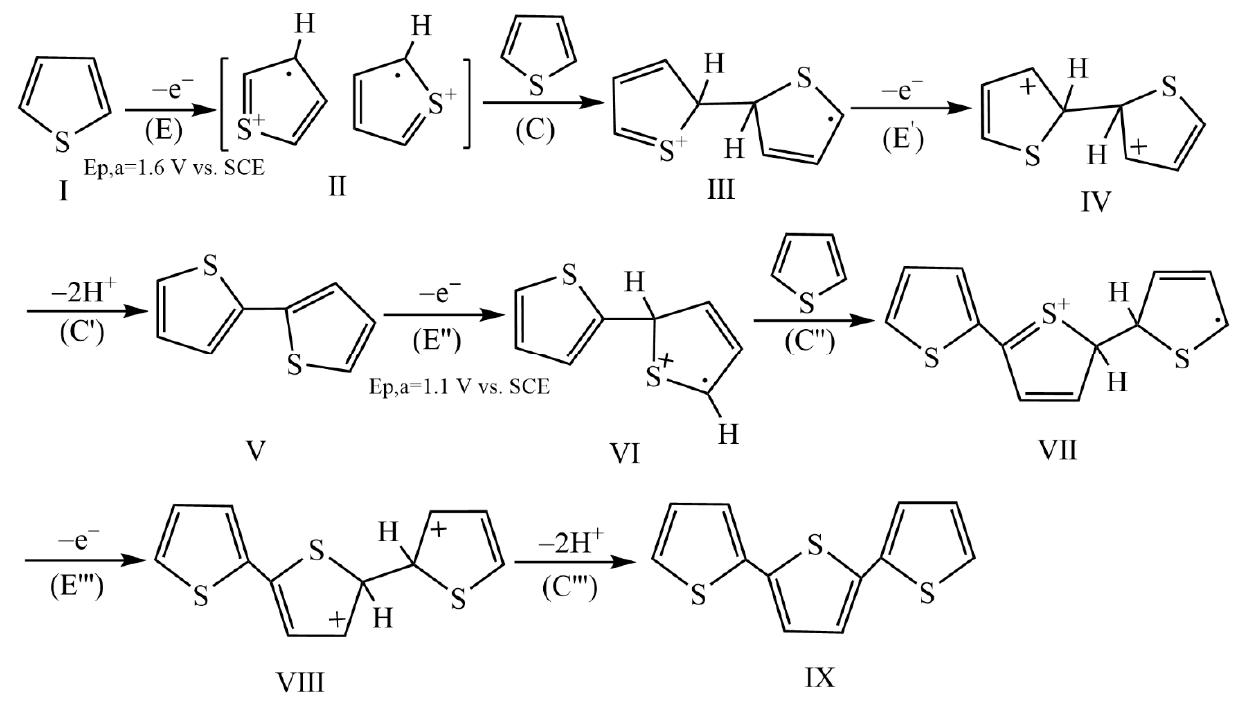
Figure 3. Basic mechanism of Th electropolymerization. Table 2. Summary of the HMIIECSs prepared by electropolymerization.